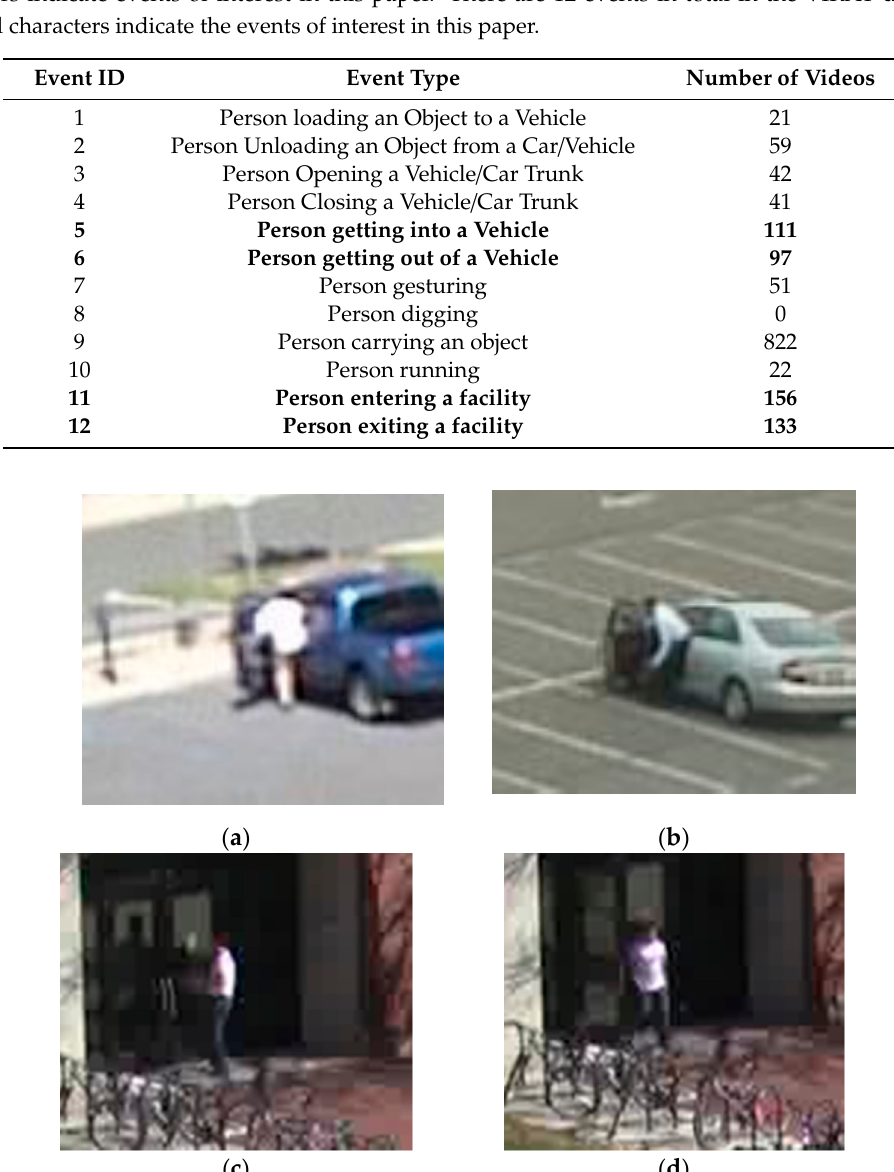
Figure 4. Sample image frames for the four investigated events from the VIRAT dataset: ( a ) a person getting into a vehicle; ( b ) a person getting out of a vehicle; ( c ) a person entering a facility; ( d ) a person exiting a